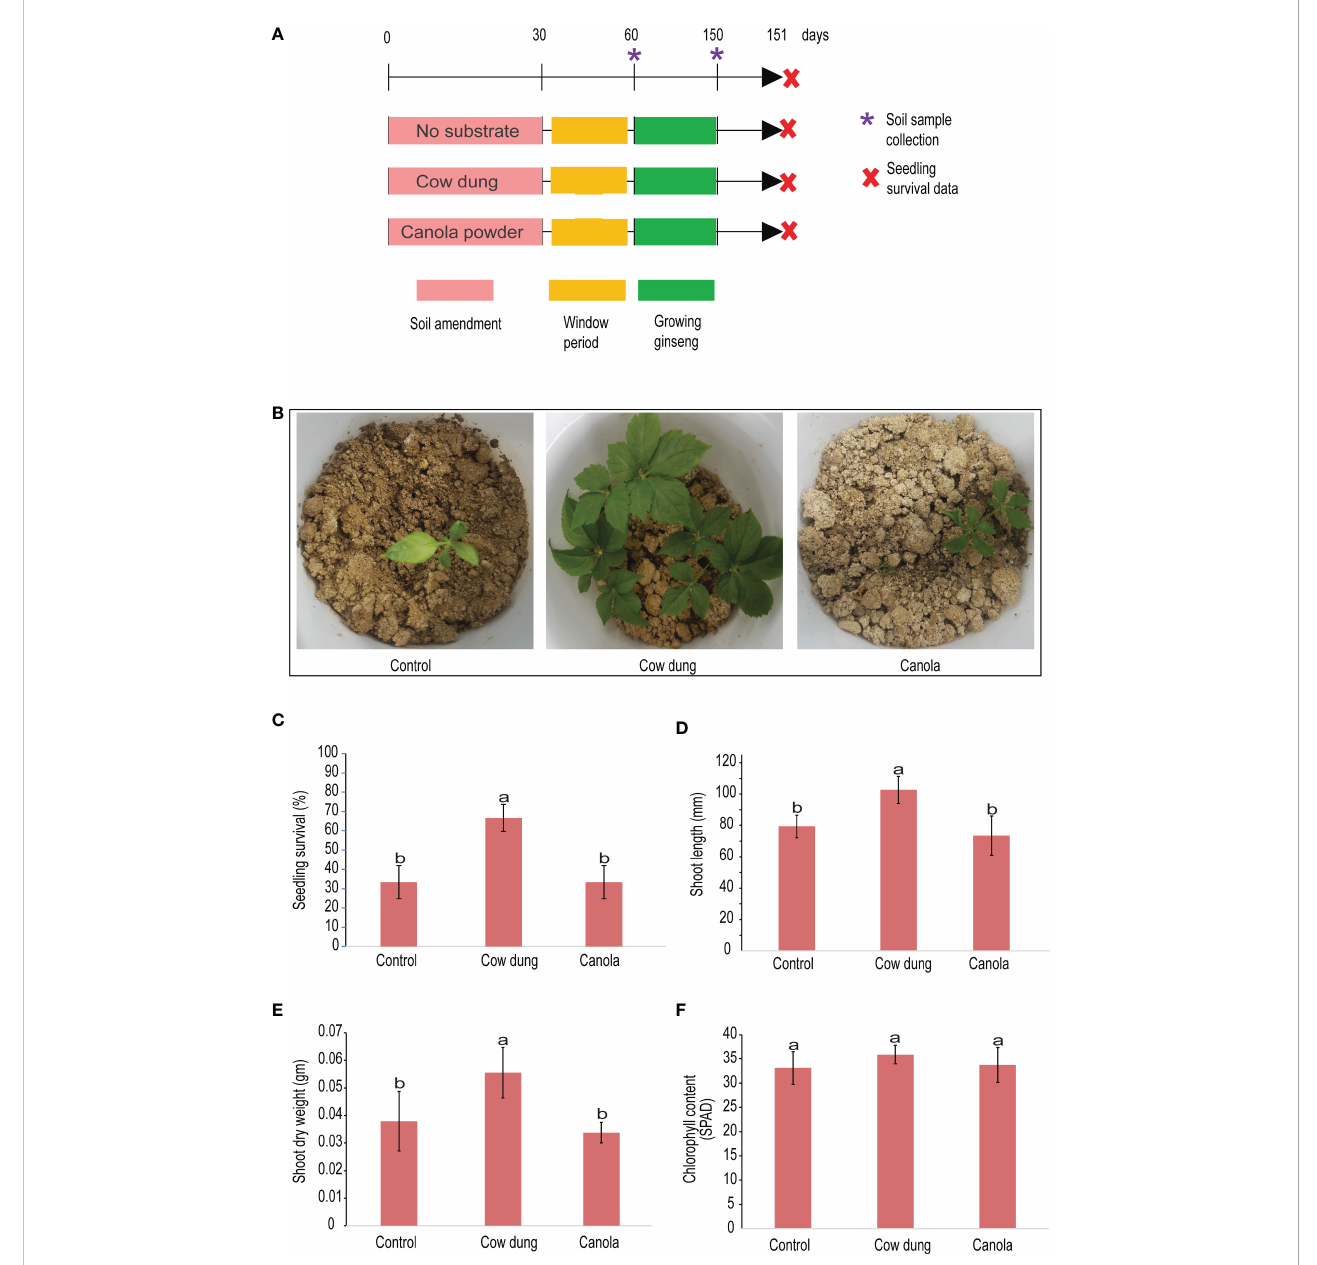
FIGURE 1 Impact of soil amendment on ginseng survival and plant growth properties. Pictorial view of the experimental scheme (A) and survived transplanted ginseng seedlings (B) . Graph showing the effect of different soil amendments on ginseng growth parameters during the three months after transplanting: the survival rate of transplanted ginseng seedlings (C) , shoot length (D) , shoot dry weight (E) , and chlorophyll content (F) . Mean values having the same letter(s) are not signi fi cantly different (p< 0.05). Error bars indicate standard deviation (n =